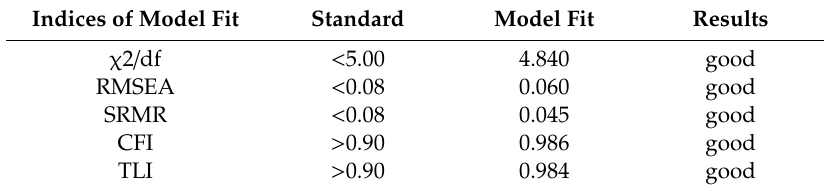
Table 4. Summary of the model fit of structural equation modeling.